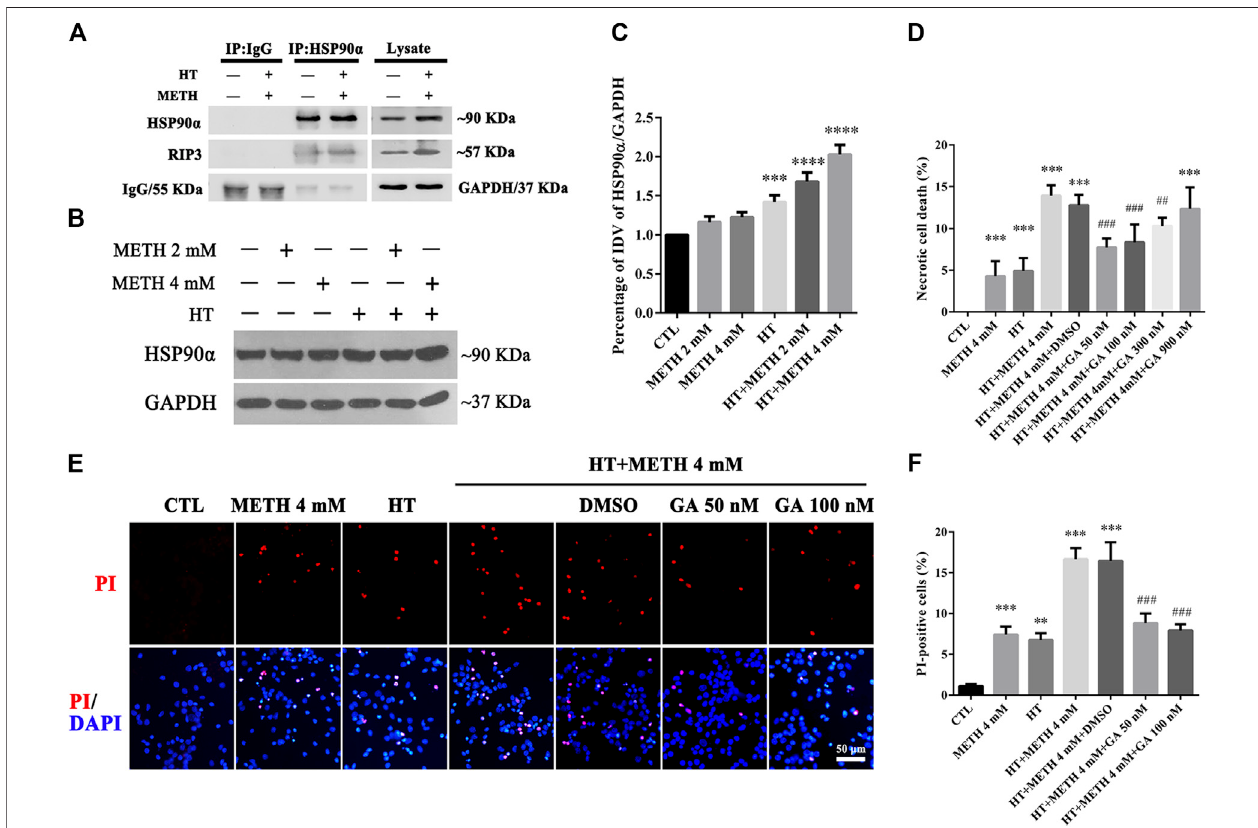
FIGURE 4 | HSP90 α interacts with RIP3 and GA pretreatment protected primary striatal neurons from METH/HT-induced necrosis. (A) Detection of HSP90 α and RIP3 interaction in primary cultures of neurons by IP (B) WB of HSP90 α expression after METH treatment for 6 h at 39.5 ° C. (C) Statistical analysis of WB of HSP90 α expression. Data were analyzed by one-way ANOVA, followed by a Tukey multiple comparisons posttest ( n (cid:2) 3). *** p < 0.001; **** p < 0.0001 vs. CTL group (D) Percentage ofnecroticneuron death after METH/HT treatment and pre-treatment with GA as determined by LDH release assays. Data were analyzed by one-way ANOVA,followed byaTukeymultiple comparisons posttest( n (cid:2) 3). *** p < 0.001vs. CTLgroup; ## p < 0.01,### p < 0.001vs. HT+METH 4 mMgroup (E) PI(red)/DAPI (blue)doublestainingofstriatalneuronsafterMETH/HTandpre-treatmentwithGA. Scalebar (cid:2) 50 μ m. (F) StatisticalanalysisofPI/DAPIdoublestainingofnecroticcells. Datawereanalyzedbyone-wayANOVA,followedbyaTukeymultiplecomparisonsposttest( n (cid:2) 3).** p < 0.01,*** p < 0.001vs.CTLgroup;### p < 0.001vs.HT+METH 4 mM